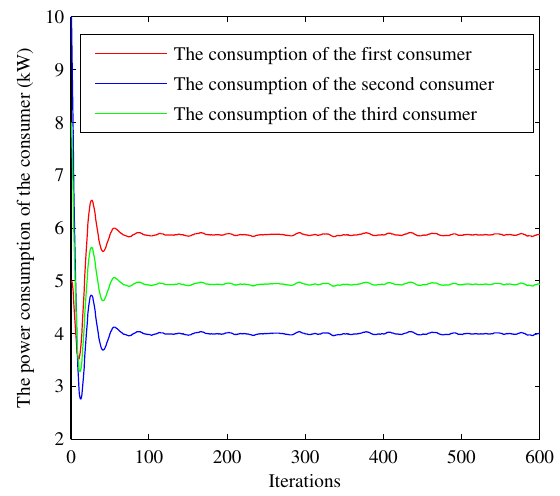
Figure 11. Convergence of the power consumption under case III.